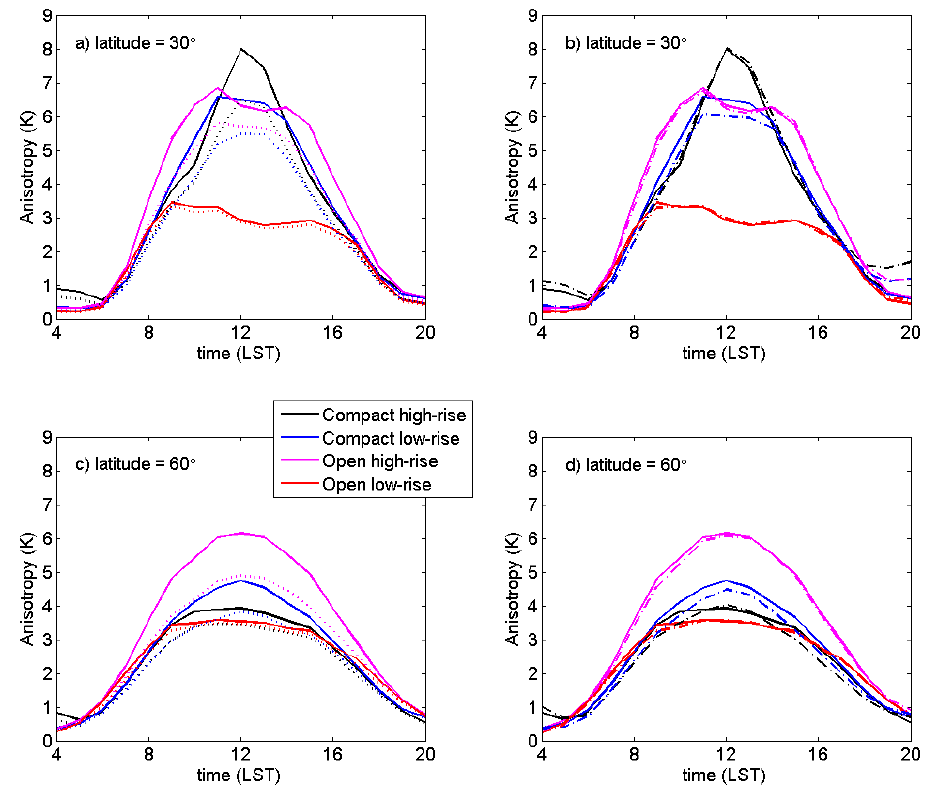
Figure 11. Diurnal evolution of TUF3D-SUM predicted maximum anisotropy ( Λ ) for four Local Climate Zones on 21 June. Solid lines indicate default material properties for each zone and the average of the anisotropy for each street orientation ( i.e. , full regularity of street orientation). ( a ) Latitude = 30°, anisotropy derived from a neighbourhood with equal coverage of all street orientations, i.e. , no regularity of street orientation (dotted lines); ( b ) latitude = 30°, anisotropy derived from neighbourhoods with identical material properties (dash-dot lines); ( c ) latitude = 60°, anisotropy derived from a neighbourhood with equal coverage of all street orientations, i.e. , no regularity of street orientation (dotted lines); ( d ) latitude = 60°, anisotropy derived from neighbourhoods with identical material properties (dash-dot lines).